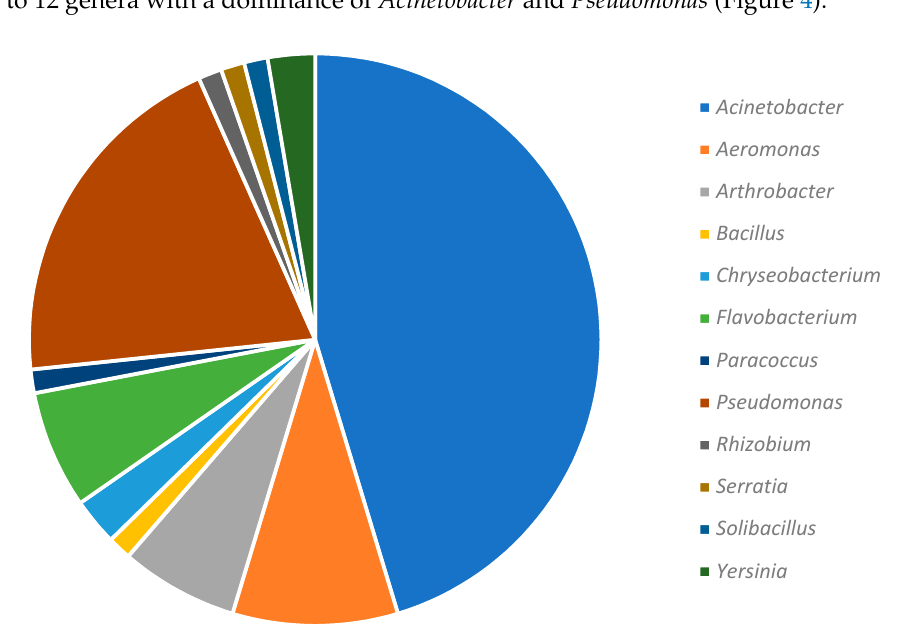
Figure 4. Taxonomic distribution of 75 bacterial strains isolated from the Infernaccio red epilithon.